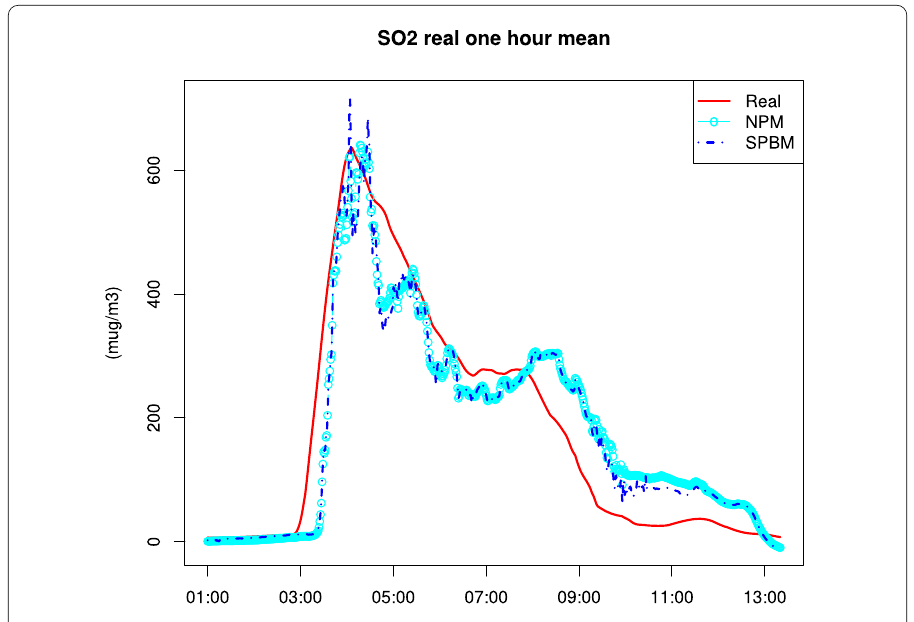
Figure 4 Episode depicted in one of the sampling stations. Predictions given by the bidimensional semiparametric models (NPM and SPBM) for the one hour SO 2 mean